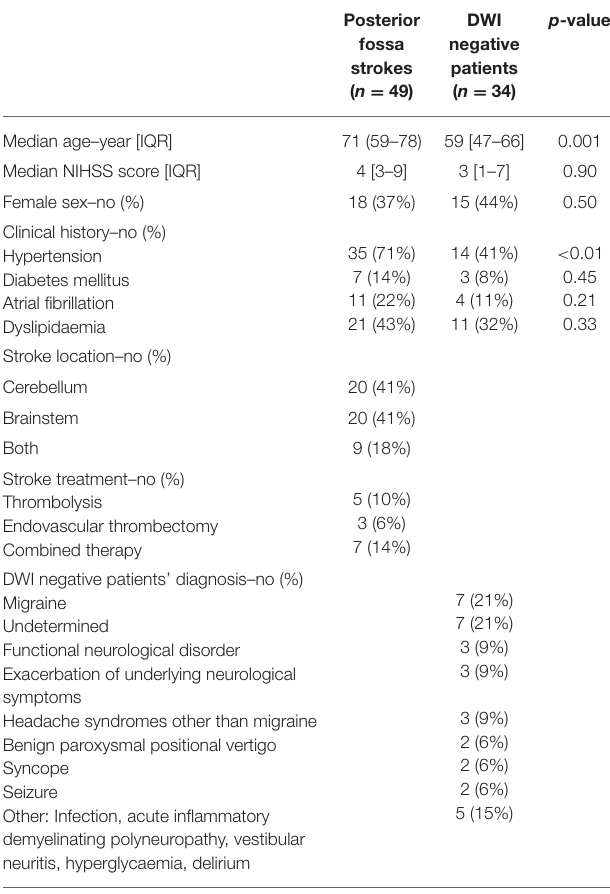
TABLE 1 | Patient characteristics of confirmed strokes and DWI negative